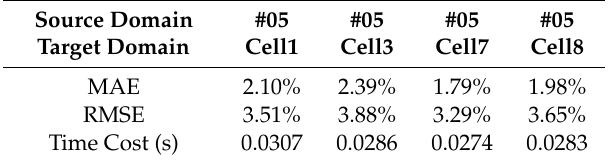
Table 2. Prediction results between Battery #05 and Cell1, Cell3, Cell7, and Cell8.